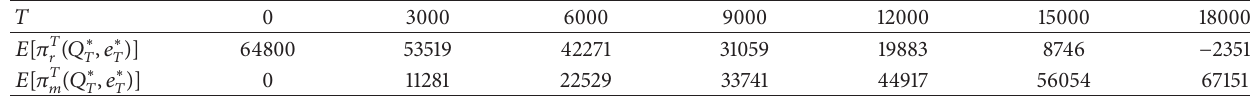
Table 3: Effect of 𝑇 on the allocation of the expected supply chain profit between two firms.